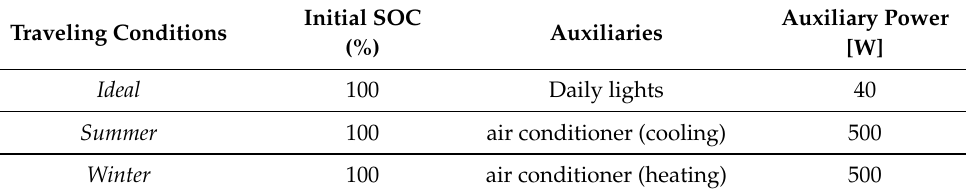
Table 2. Traveling conditions of the